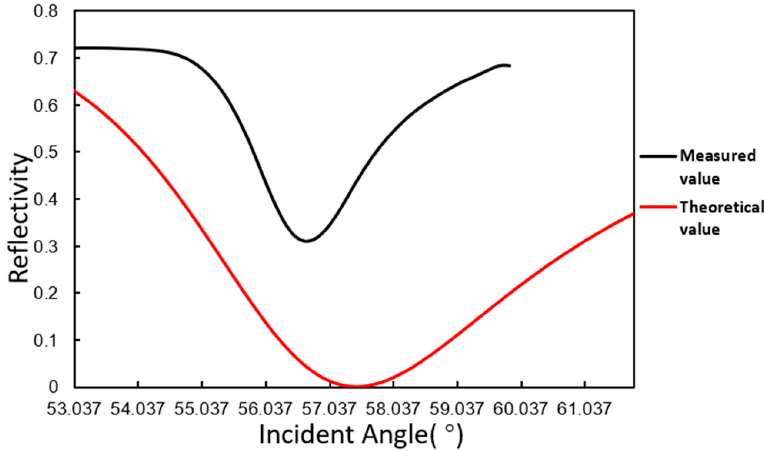
Figure 4. Angle scanning curve of deionized water.